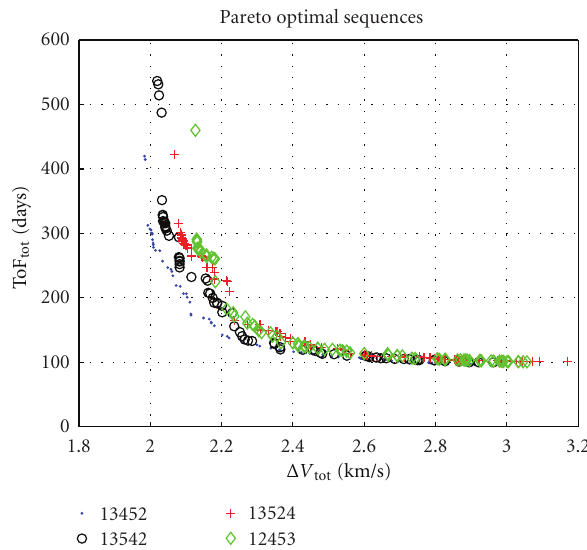
Figure 17: Pareto fronts corresponding to the four best sequences according to Conv .